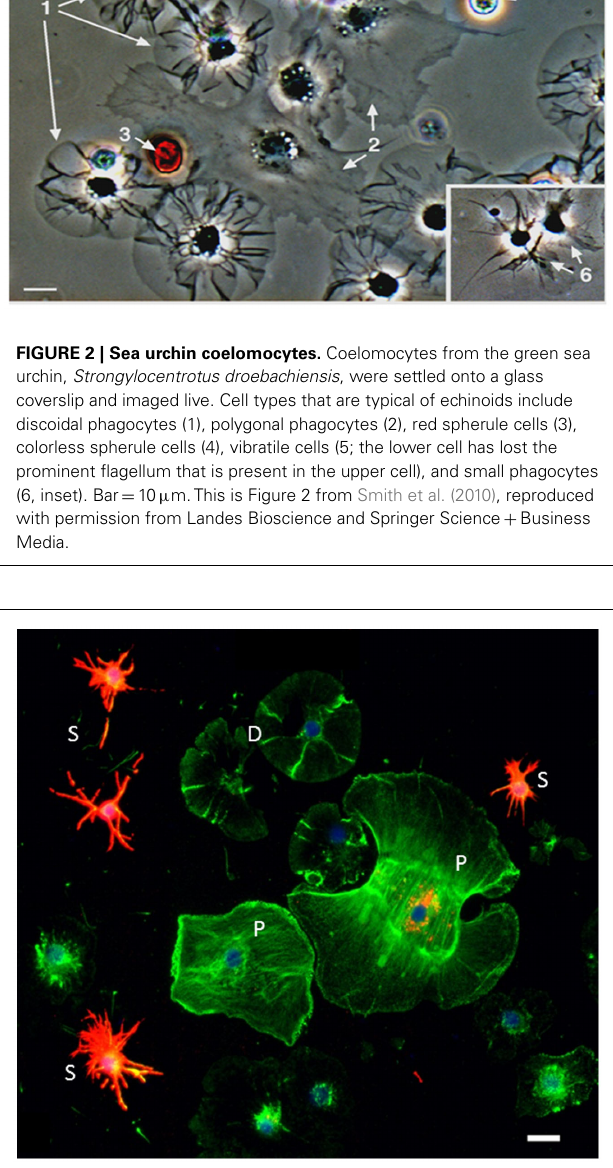
be mediated by the colorless spherule cells that is augmented by the presence of phagocytes (Arizza et al.,